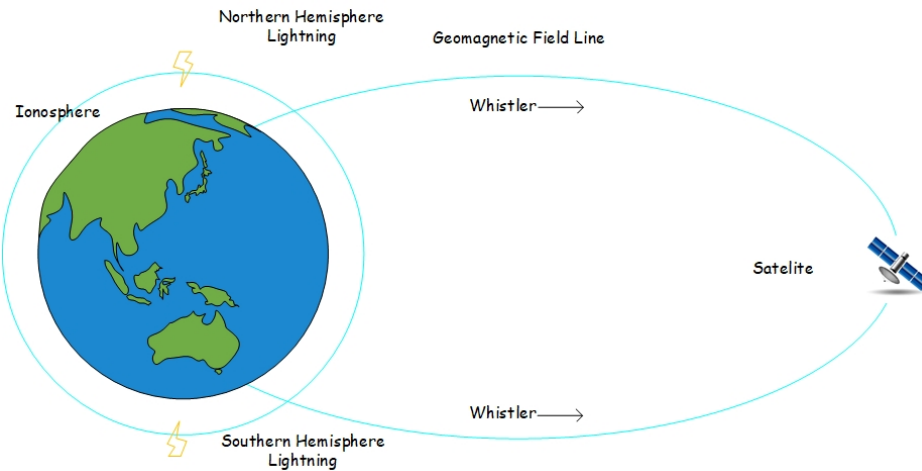
Figure 1. Propagation of lightning whistlers along the magnetic field